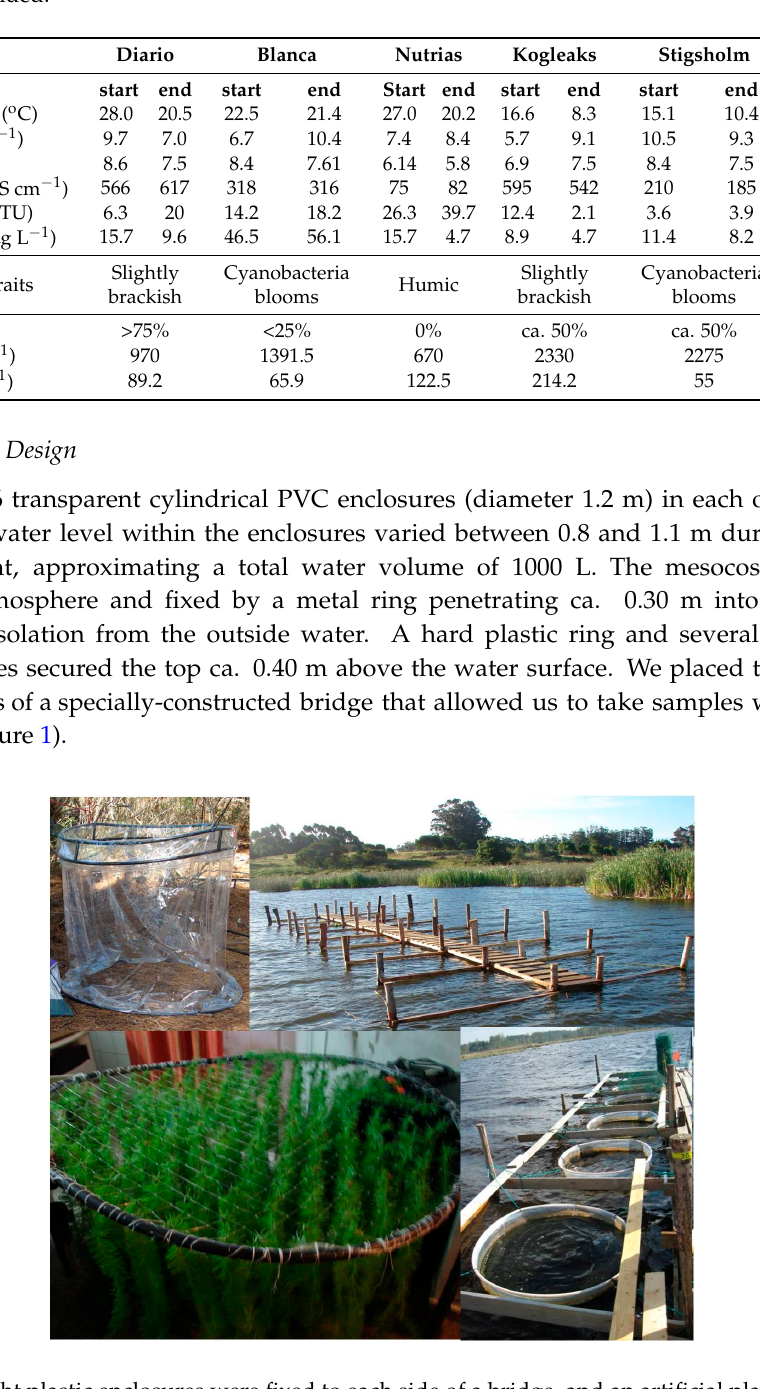
Table 1. Main limnological parameters of the lakes where the experiments were conducted. Shaded = subtropical Uruguayan lakes (30–35° S) and non-shaded = temperate Danish lakes (55–57° N). Shown are mean temperature, dissolved oxygen concentration (DO 2 ), pH, water turbidity (Nephelometric Turbidity Unit, NTU) and concentration of phytoplankton chlorophyll-a (Chl-a) at the beginning (start) and at the end of the experiments. Distinctive traits of the lakes, including submerged plant percentage of volume inhabited (PVI), total nitrogen (TN) and total phosphorus (TP) concentrations, are also provided. Diario Blanca Nutrias Kogleaks Stigsholm